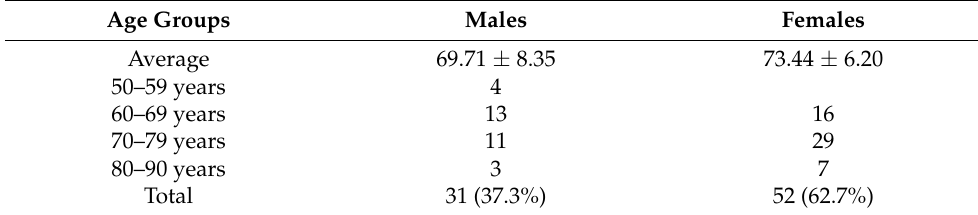
Table 1. Age distribution by gender.